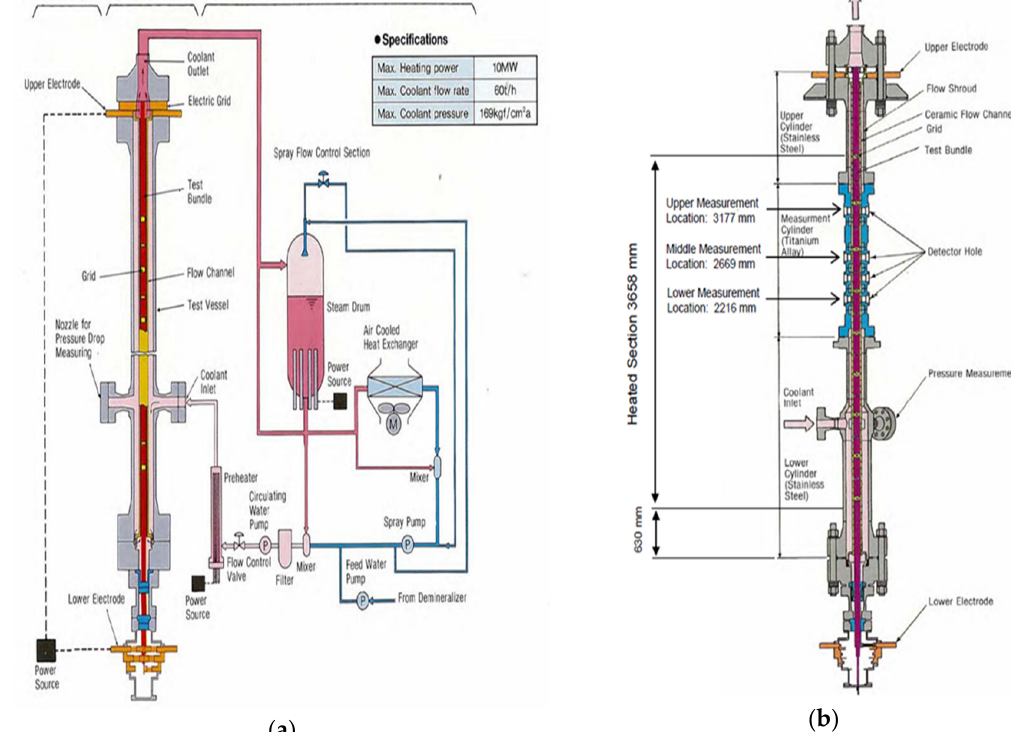
Figure 2. NUPEC test facility [8]: ( a ) whole scheme of the test recirculation loop; ( b ) scheme of the test section where bundle void measurement tests were performed.